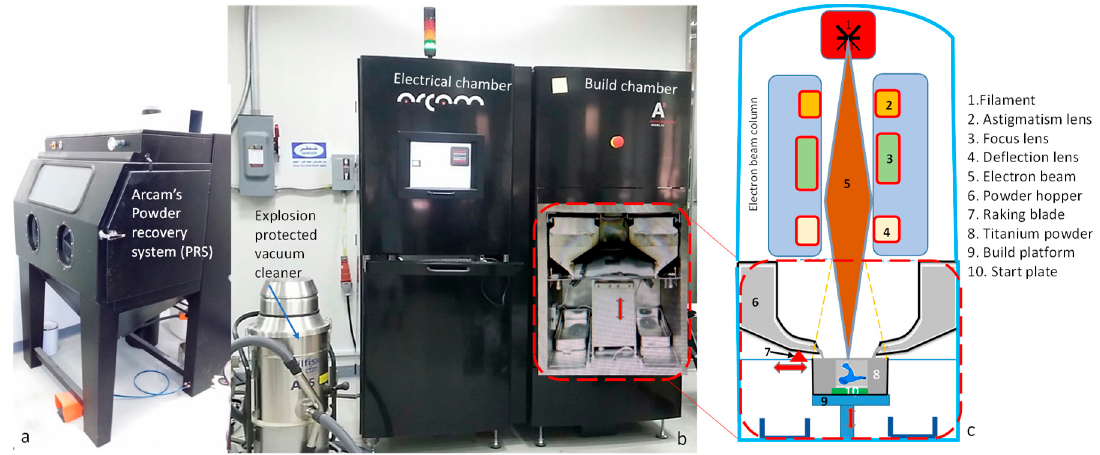
Figure 7. ( a ) ARCAM powder recovery system unit to remove the sintered powder attached to the build part, ( b ) ARCAM A2 electron beam melting machine, and ( c ) the schematic working diagram